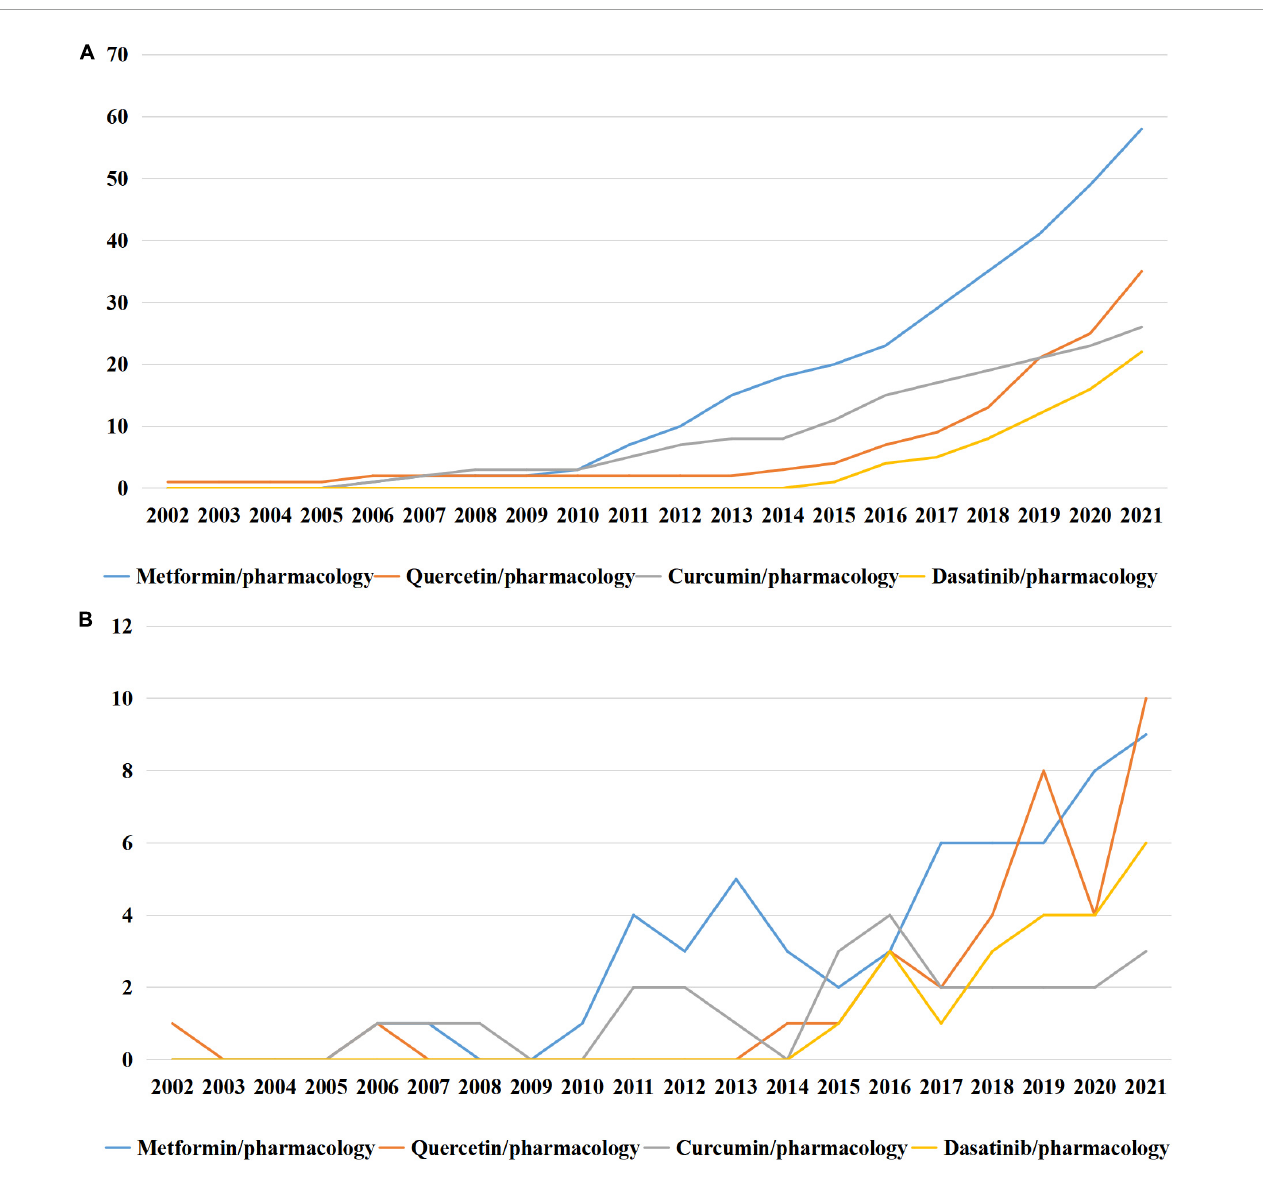
FIGURE6 Medical subject headings (MeSH) terms in relate to senolytics and senomorphics. (A) Accumulated occurrences; (B) annual